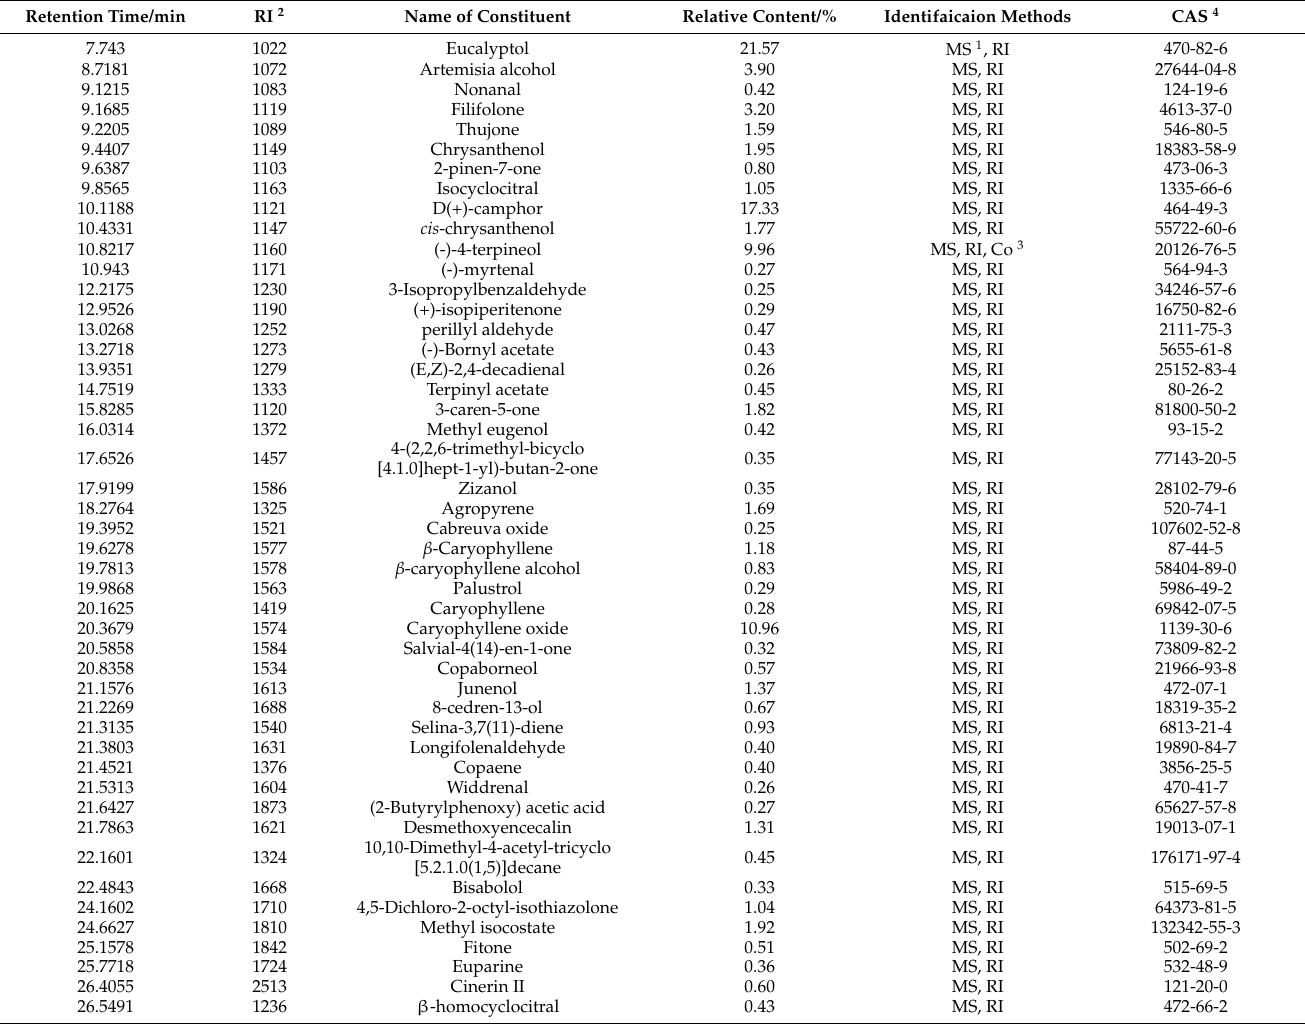
Table 1. Chemical constituents and relative contents of the essential oil from A. lavandulaefolia